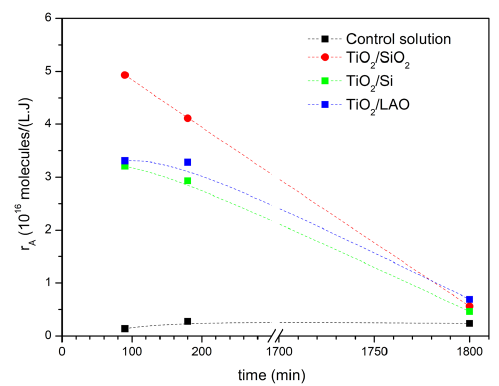
Figure 3. Rate of the reactor in 10 16 molecules/(L.J) up to 1800 minutes in the 13 th cycle of the photocatalytic test comparing three different substrates. The dot lines are just a guide to the